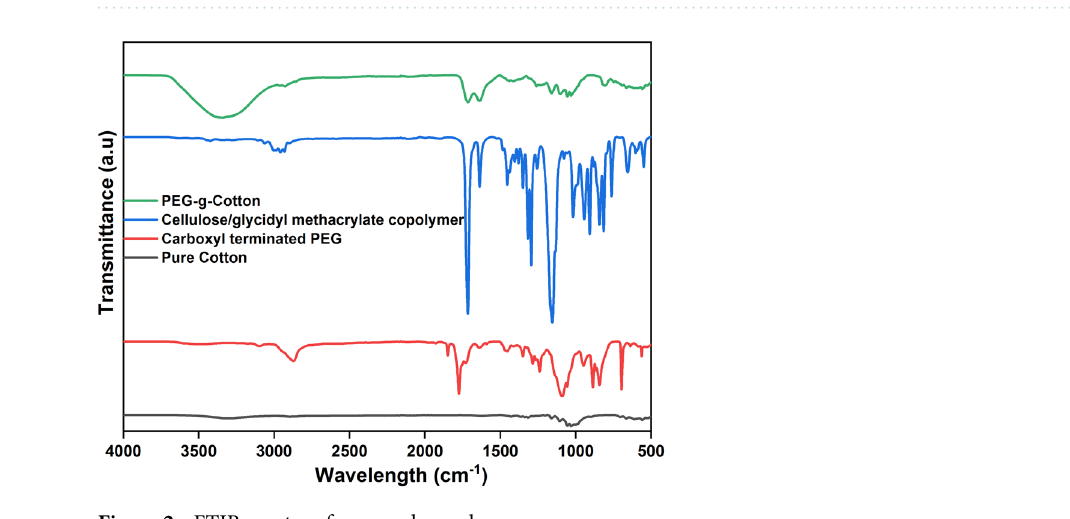
Figure 2. FTIR spectra of prepared